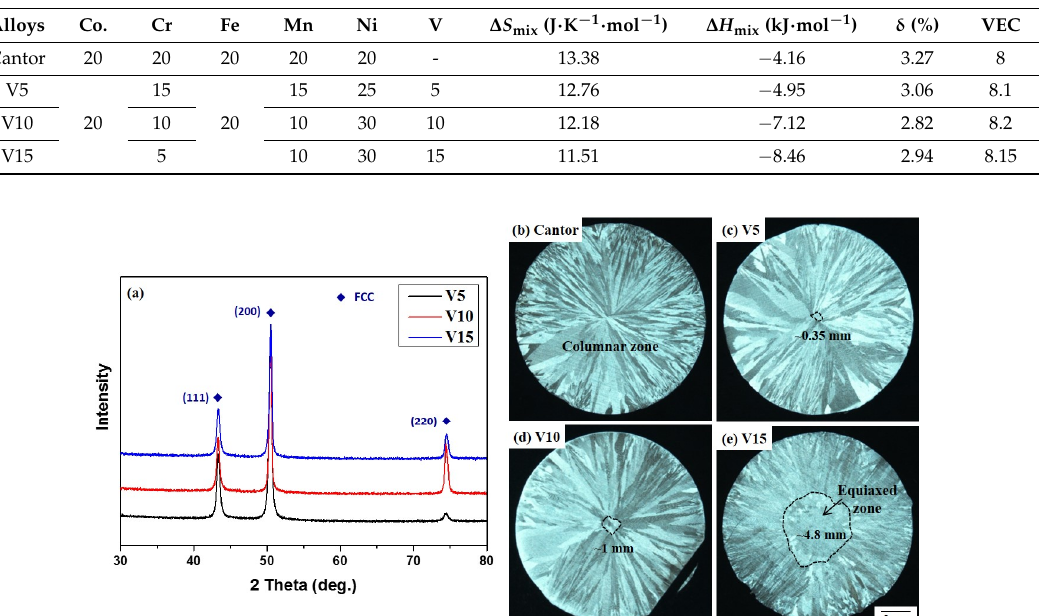
Figure 3. ( a ) XRD profiles of newly designed HEAs; Images of the macroscopic grains of ( b ) Cantor; ( c ) V5; ( d ) V10; and ( e ) V15 alloys. All HEAs consisted of fcc single phase. The area of the equiaxed zone increases with increased concentration of V.